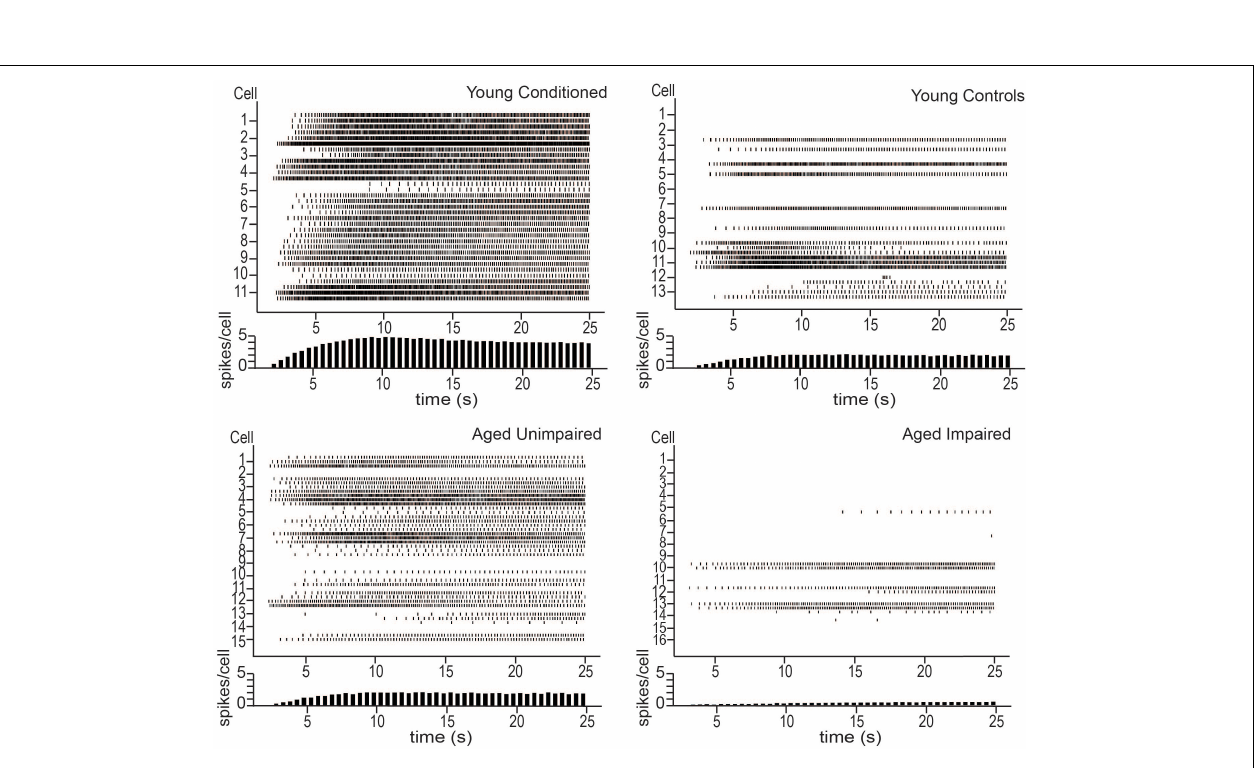
FIGURE 1 | Persistent firing example trace from an LEC neuron evoked with depolarizing current injection using in vitro electrophysiology. Persistent firing activity of the neuron evoked with whole cell current clamp (top trace). A 100 pA, 2 s long depolarizing current (bottom trace, protocol as reported in Tahvildari et al., 2008) was injected into the neuron, eliciting an initial 2 s burst of action potentials. Even after the termination of the depolarizing current injection, the neuron continues to fire action potentials. From Lin (2020).